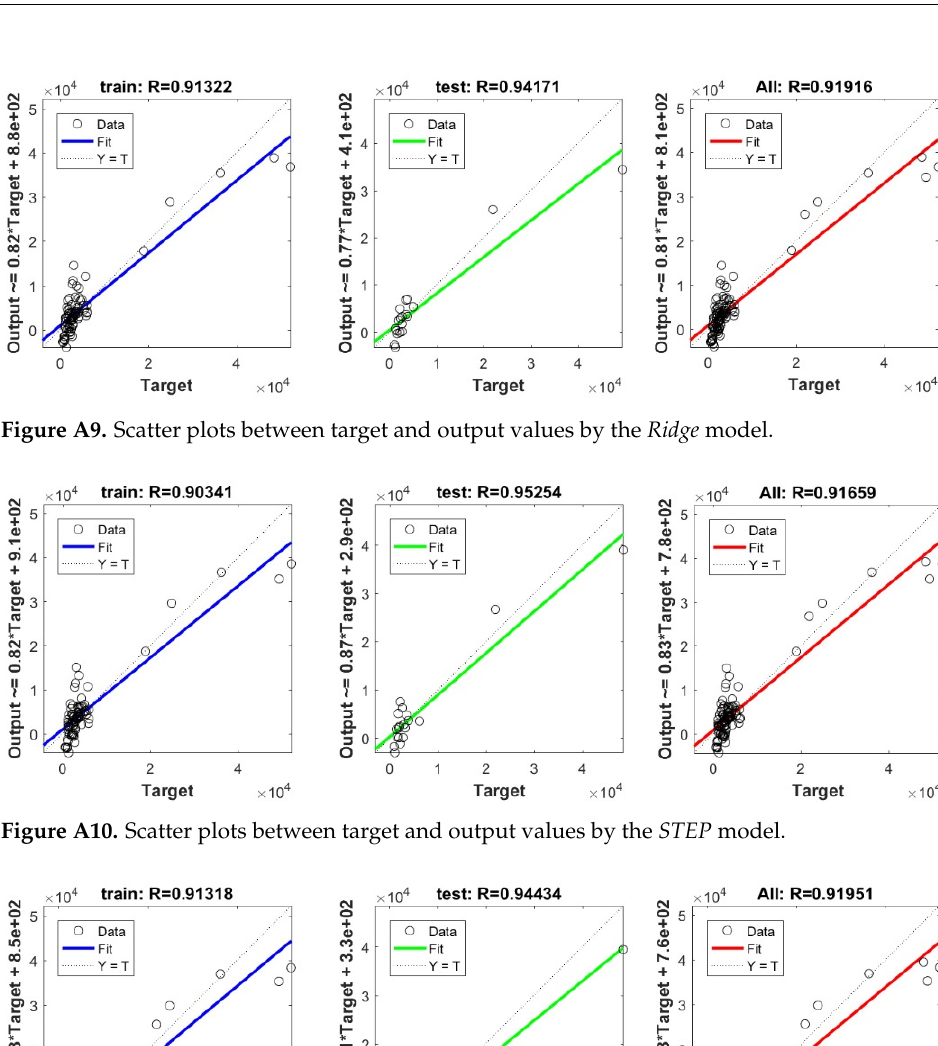
Figure A8. Scatter plots between target and output values by the RF model.